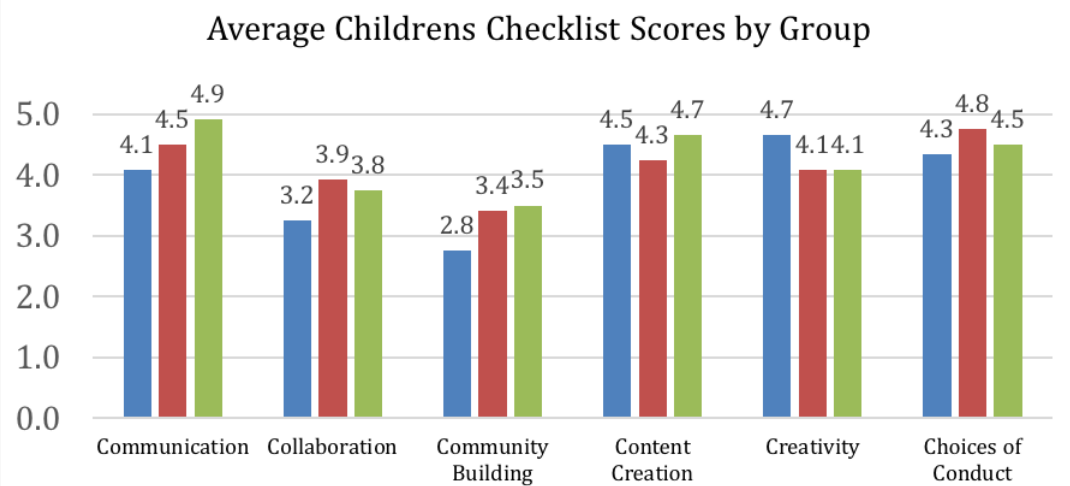
Figure 6. This chart displays the average number of times per session that separate. Group 1 is shown above in blue, group 2 is in red, and group 3 is in